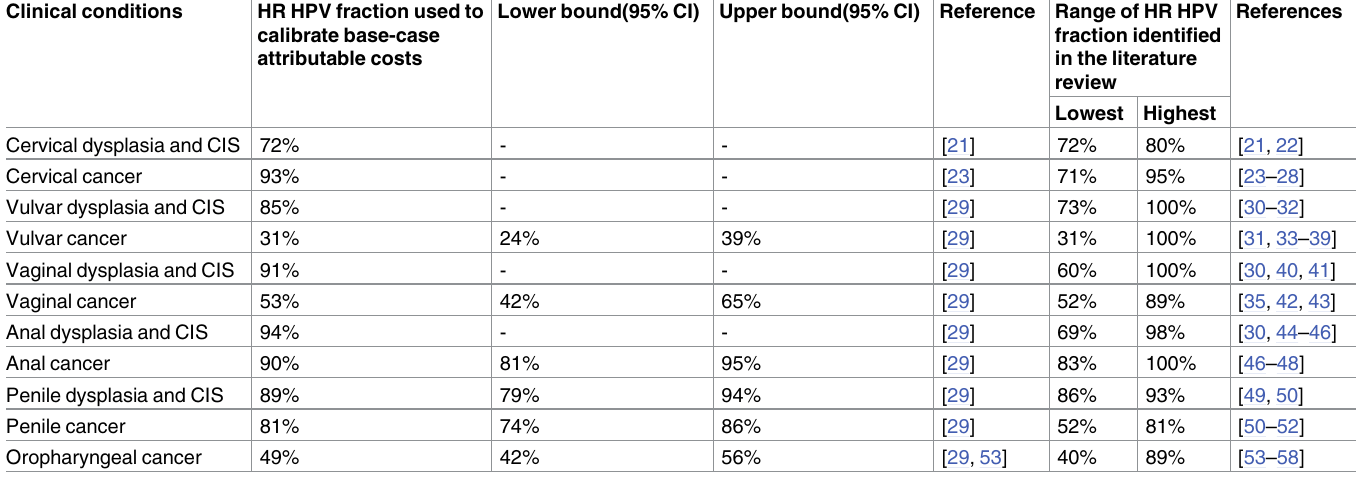
Table 1. HR HPV * -attributable fraction reported in the articles from the literature review by precancer and cancer site. Clinical